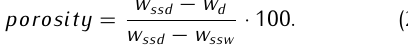
Figure 4. The size distributions of the OPC and RHA